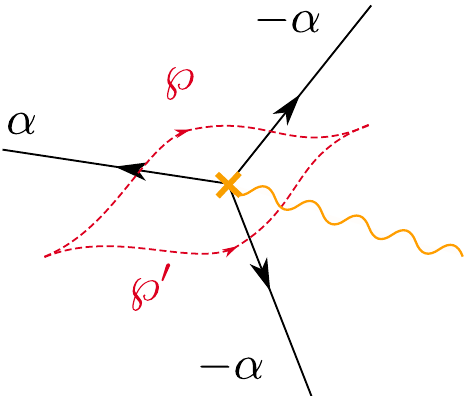
Figure 2. A branch point with three emerging S -walls. Two homotopic paths }; } 0 are also shown.